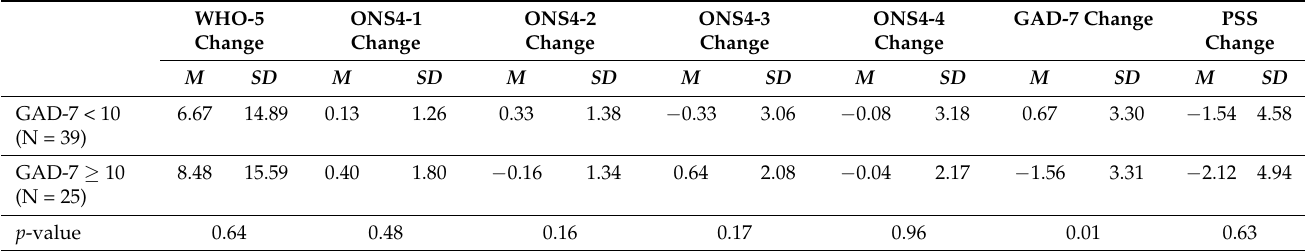
Table 7. One-way ANOVA between change in clinical outcome and baseline anxiety on GAD-7. WHO-5